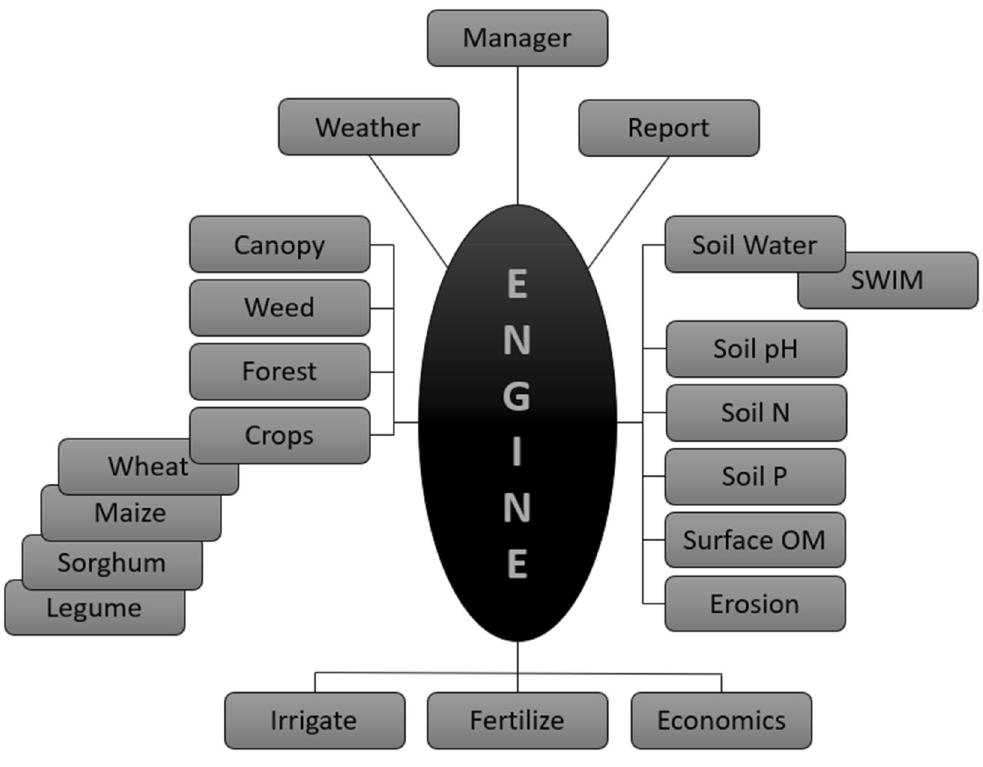
Figure 2. Modules and engine of APSIM 38,53,69,70